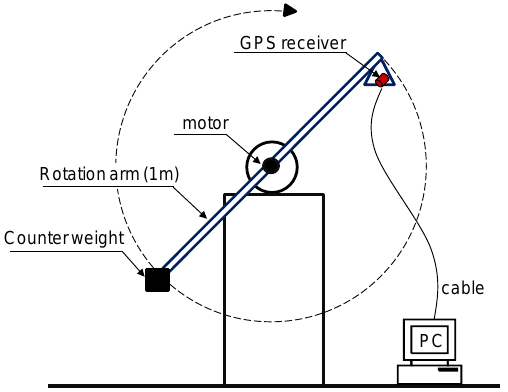
Figure 2. The dynamic simulator used in the laboratory